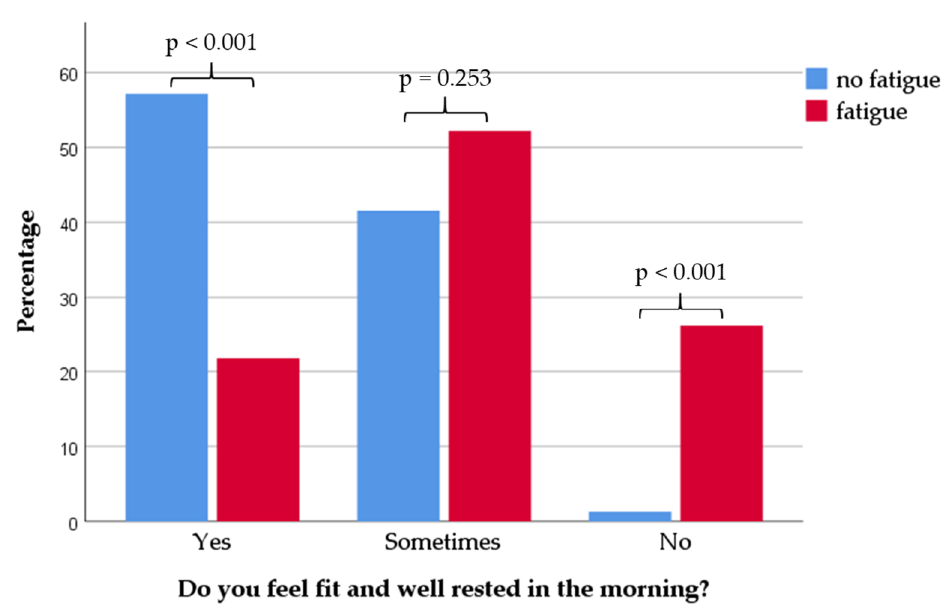
Figure 1. Distribution of sleep quality data in the two groups “fatigue” and “no fatigue”. Patients with fatigue ( n = 46) stated to feel less active and well rested in the morning ( p < 0.001), whereas patients without fatigue ( n = 78) felt more fit in the morning ( p < 0.001; p , statistical significance).